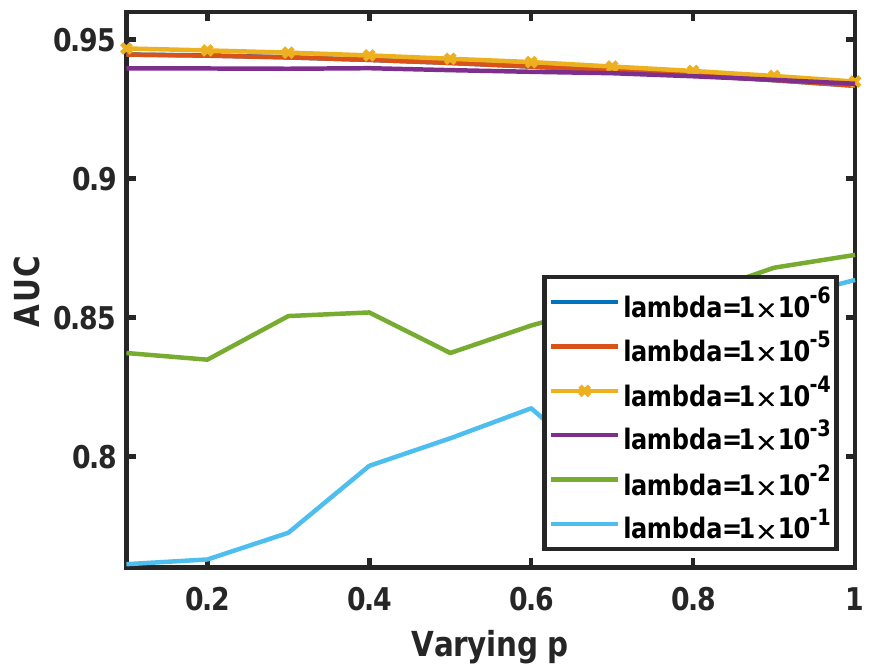
Figure 9. AUC values of different varying p , as well as lambda ( λ ), in the HyMap